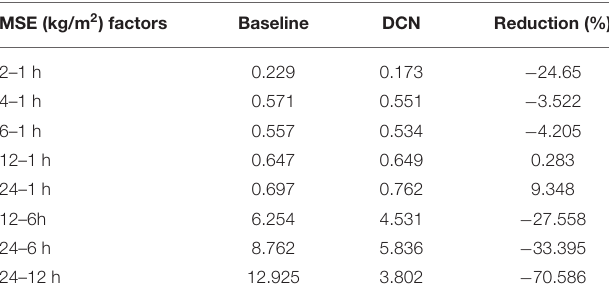
TABLE 3 | Observation downscaling results in temporal dimension, using the baseline and our